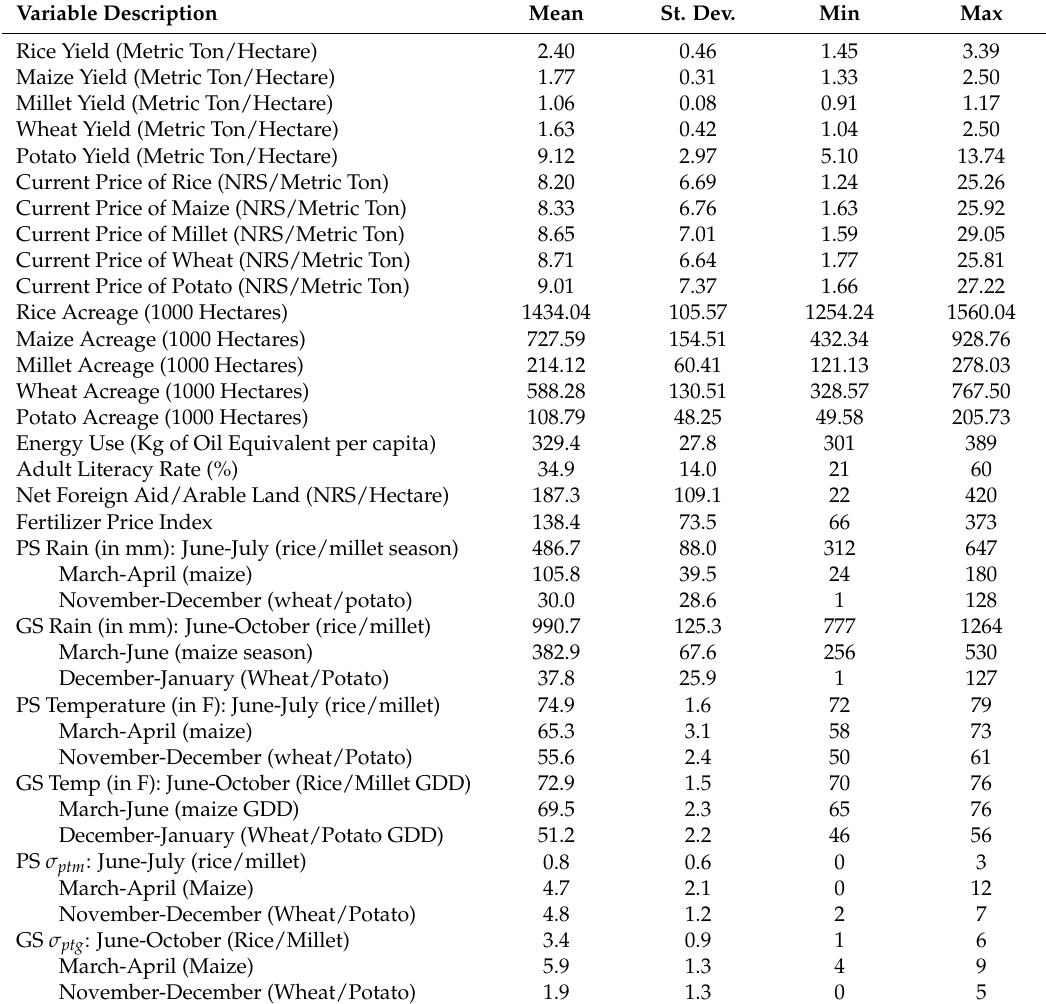
Table 1. Summary Statistics for Variables Included in the Regression